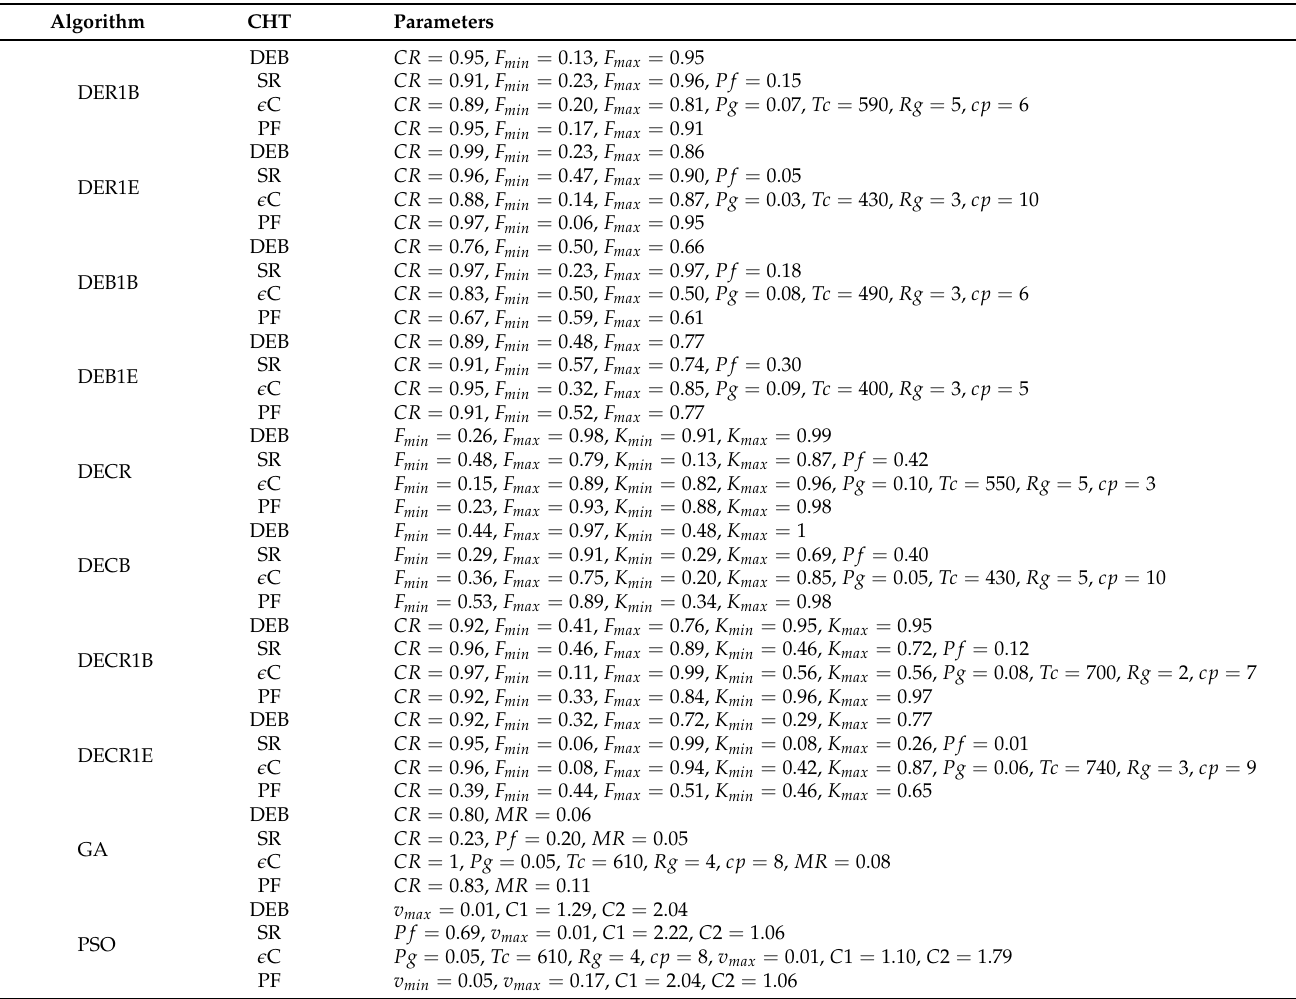
Table A4. Tuned parameters by irace program for study case 1: Four-bar linkage